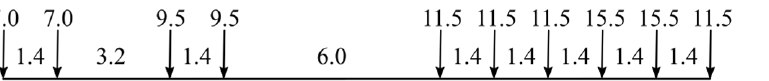
Figure 6. Axle load distribution for a class 100 vehicle in the Danish classification system [21], axle loads in tons and spacing in meters.